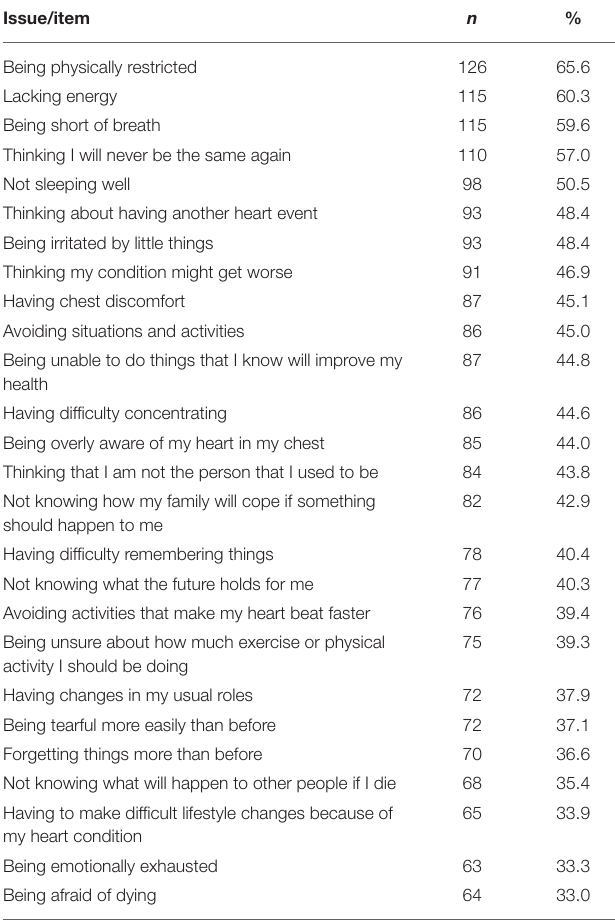
TABLE 2 | Prevalence of issues and concerns in rank